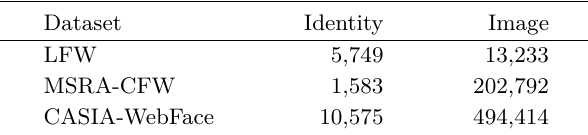
Table 1 Datasets used in